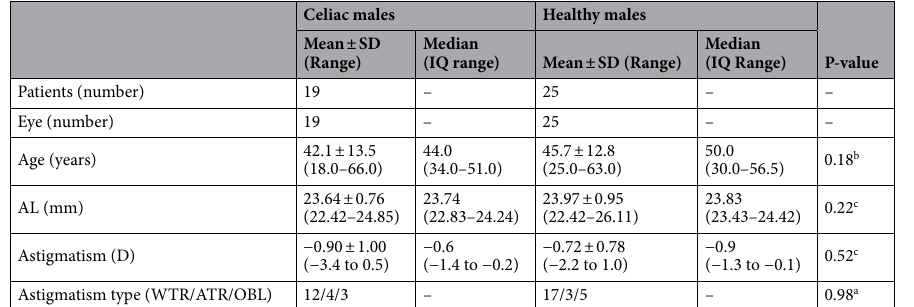
Table 2. Demographic characteristics of the two male groups. a Chi-square test with Yates correction. b Mann